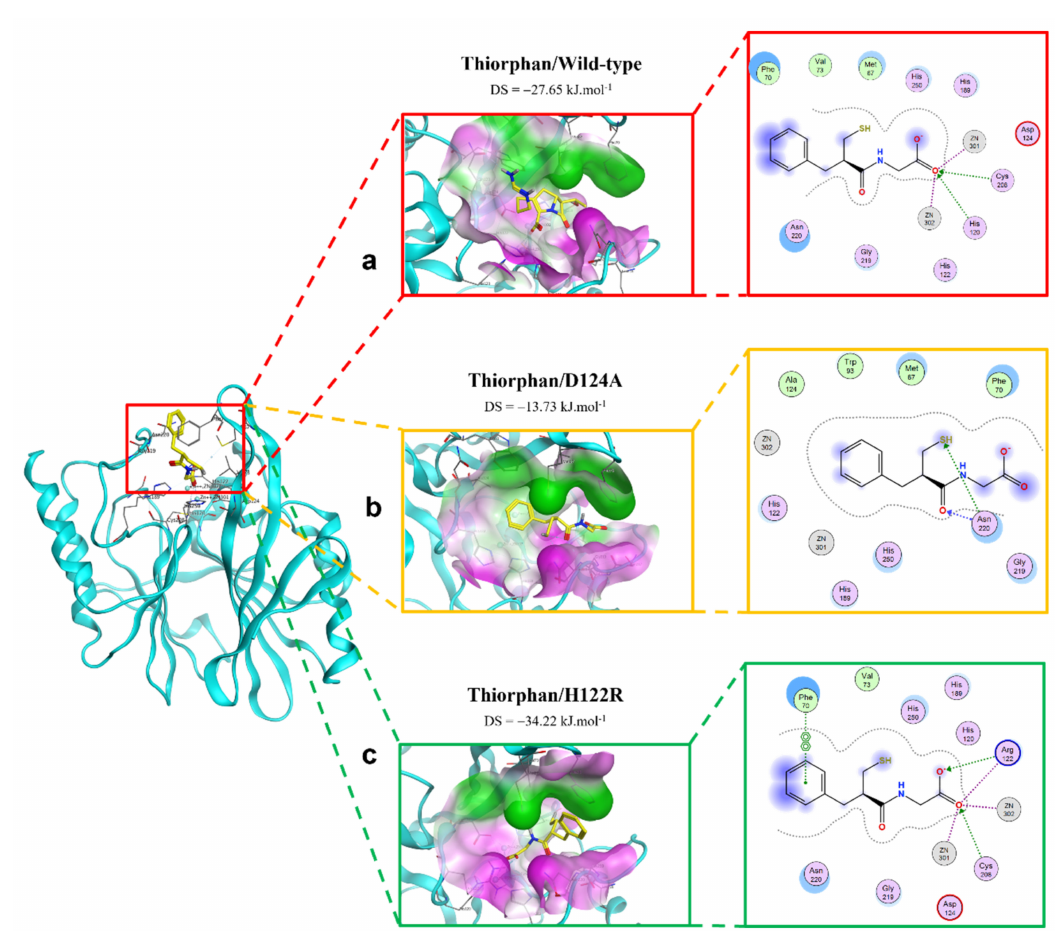
Figure 6. The binding site of thiorphan with NDM-1 wild-type and mutant proteins. ( a ) Wild